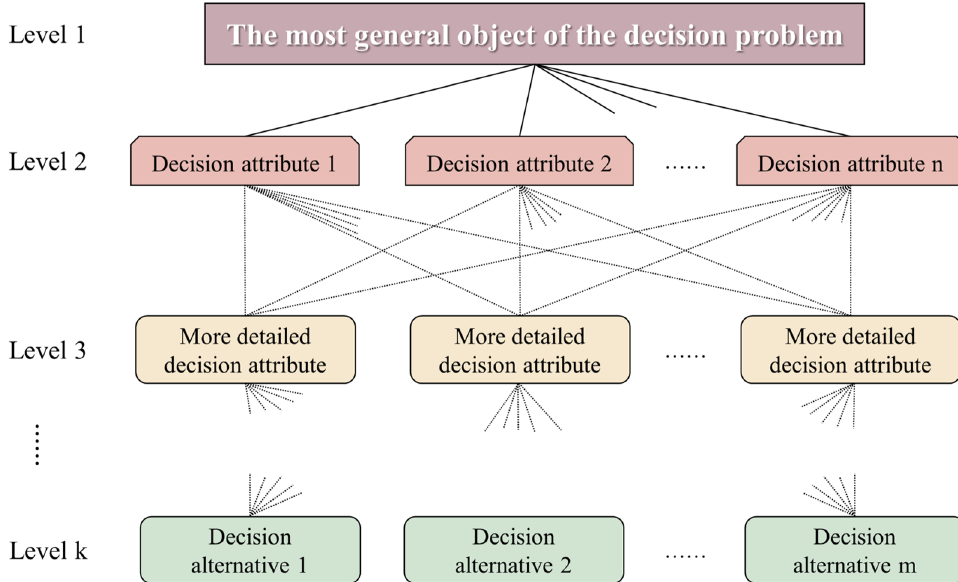
Fig. 5 Form of decision elements in the AHP (modified from Zahedi